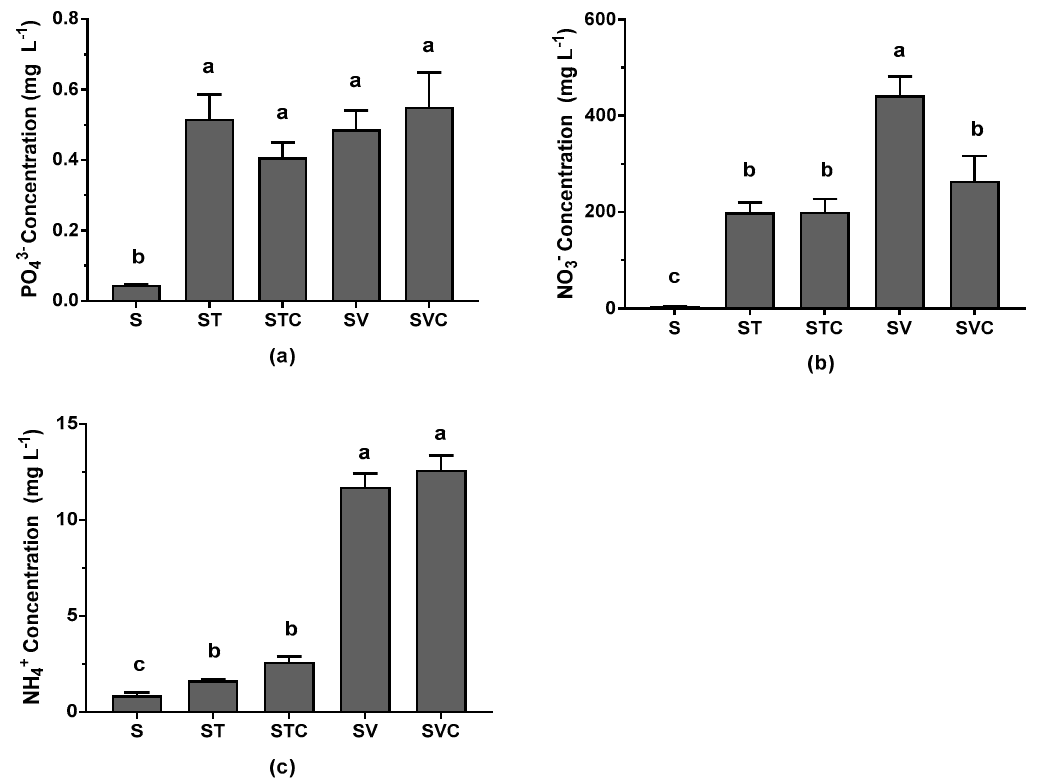
Figure 4. ( a – c ) Mean ± 1 S.E. PO 43 − , NO 3 − , and NH 4+ concentrations analyzed in the leachate from control soil (S), and control soil amended with thermophilic (T) and vermicompost (V) with and without coir (C) from pots containing no plants. Varying letters indicate significant differences in nutrient leachate concentrations across treatments.